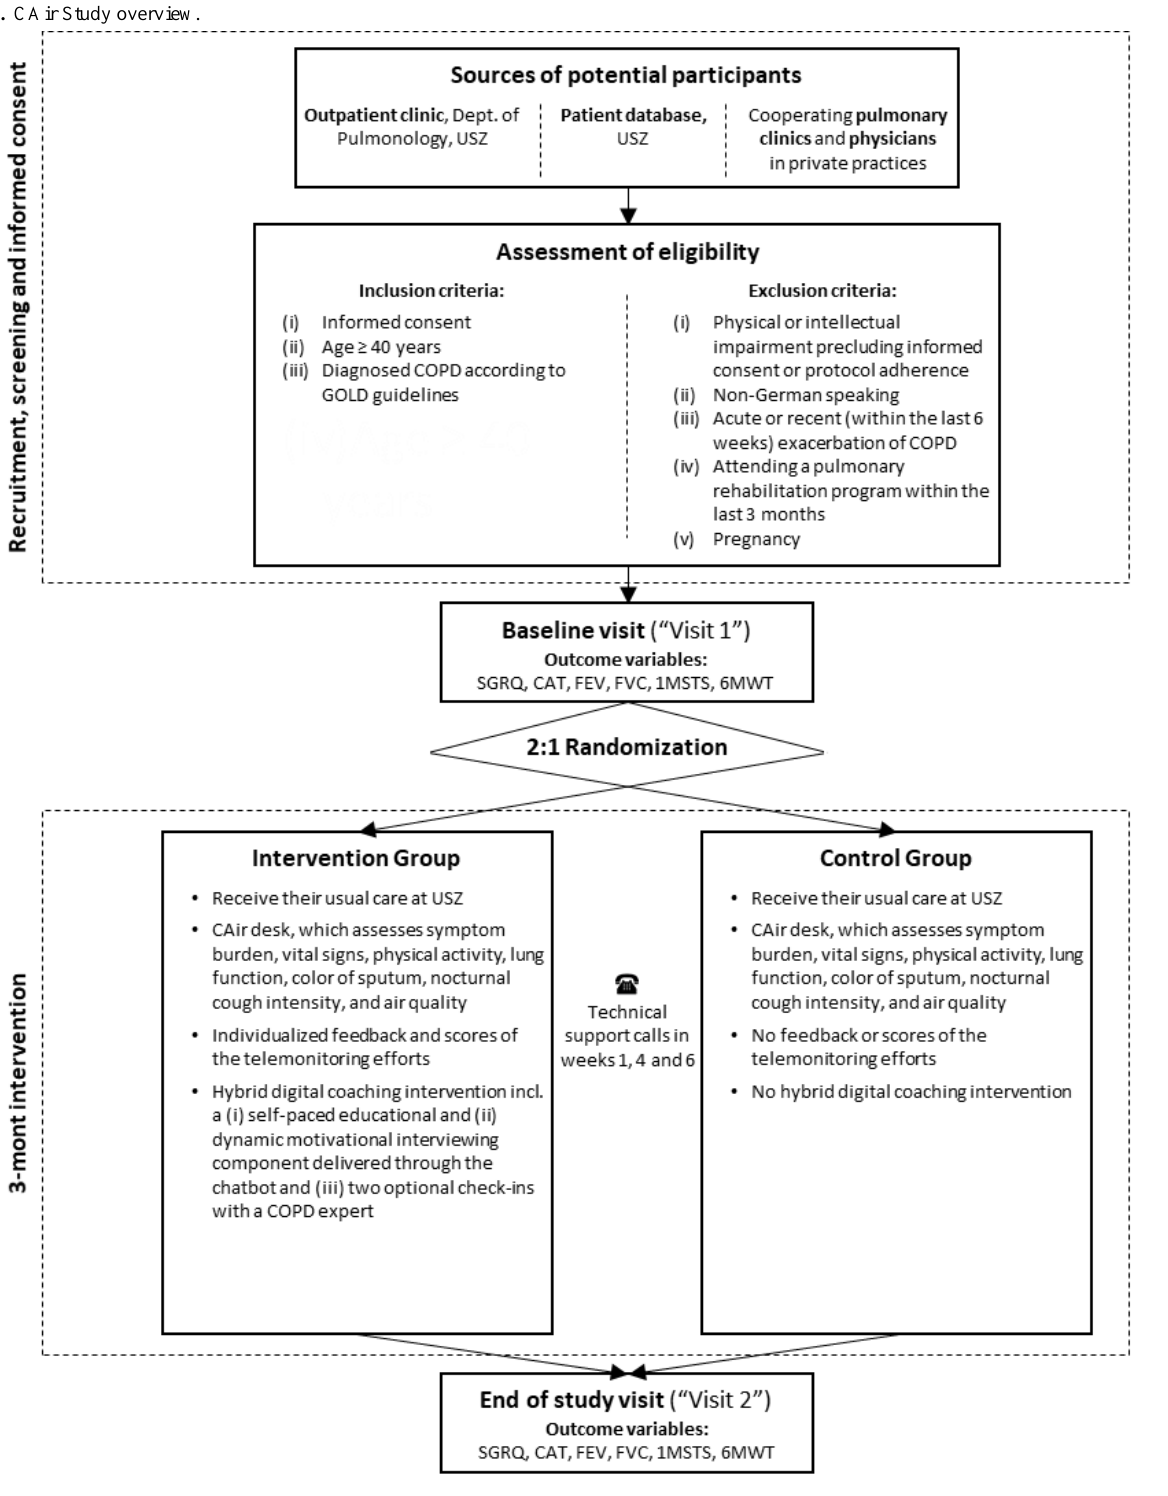
Figure 3. CAir Study